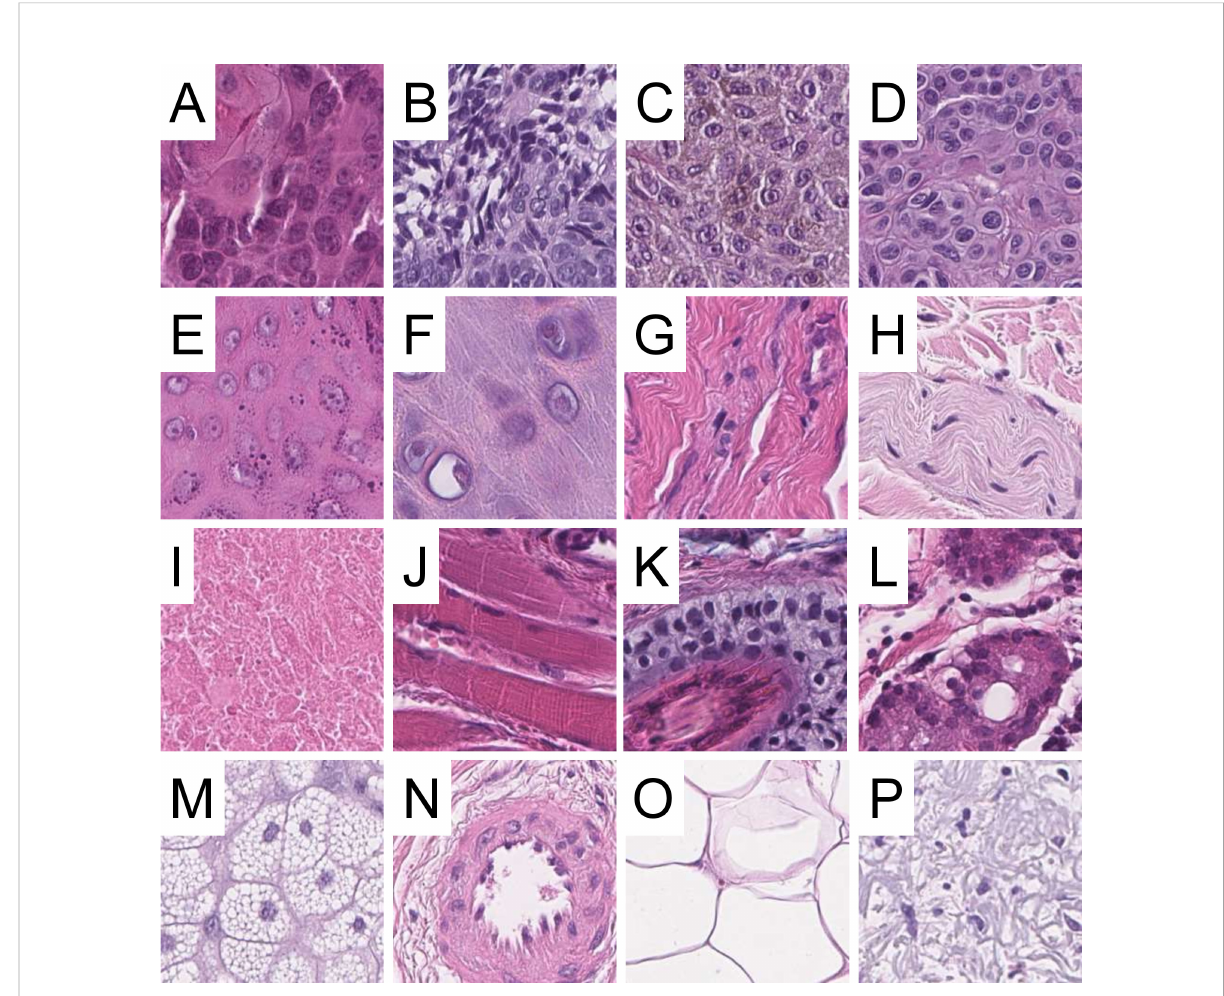
FIGURE 1 Examples of image patches included in the dataset. Squamous cell carcinoma (A) , basal cell carcinoma (B) , melanoma (C) , naevi (D) , epidermis (E) , chrondral tissue (F) , dermis (G) , nerves (H) , necrosis (I) , skeletal muscle (J) , hair follicles (K) , sweat glands/eccrine glands (L) , sebaceous glands (M) , vessels (N) , subcutis (O) and elastosis (P) . All images are 100 x 100 µm (395 x 395 px) in size, scale bar = 20